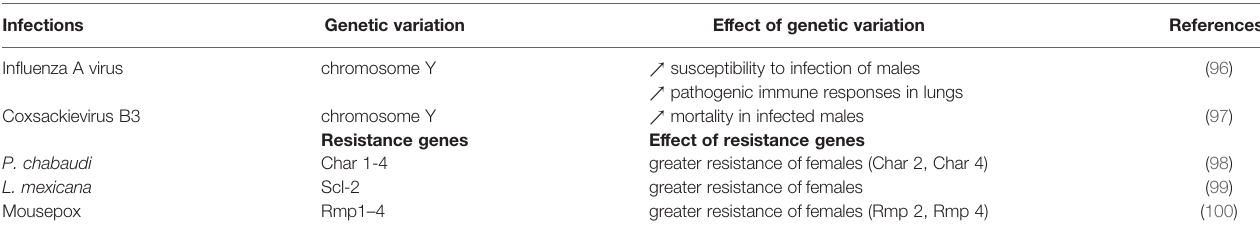
TABLE 3 | Genetic susceptibility to infections in